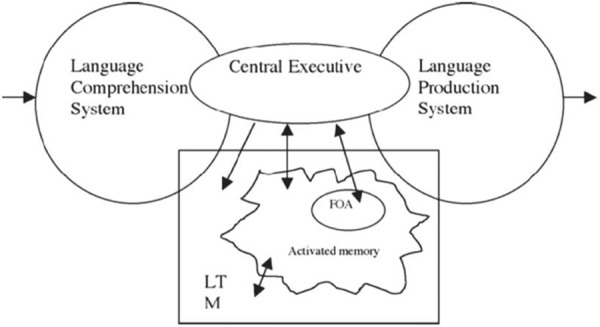
The process model of working memory (WM) and interpreting by Mizuno (2005, p. 744).